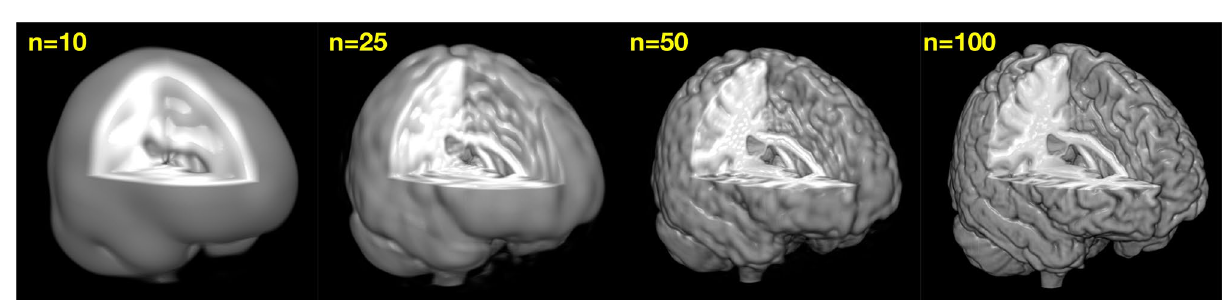
Figure 12. The model order problem in volumetric SWD analysis. The optimal fit shown in Fig. 10B was determined by searching through a range of model orders n (shown in yellow) and determining statistically which value first reduced the mean squared error to a minimum to within the noise (the equivalent of p Fig. 11). See 42 for